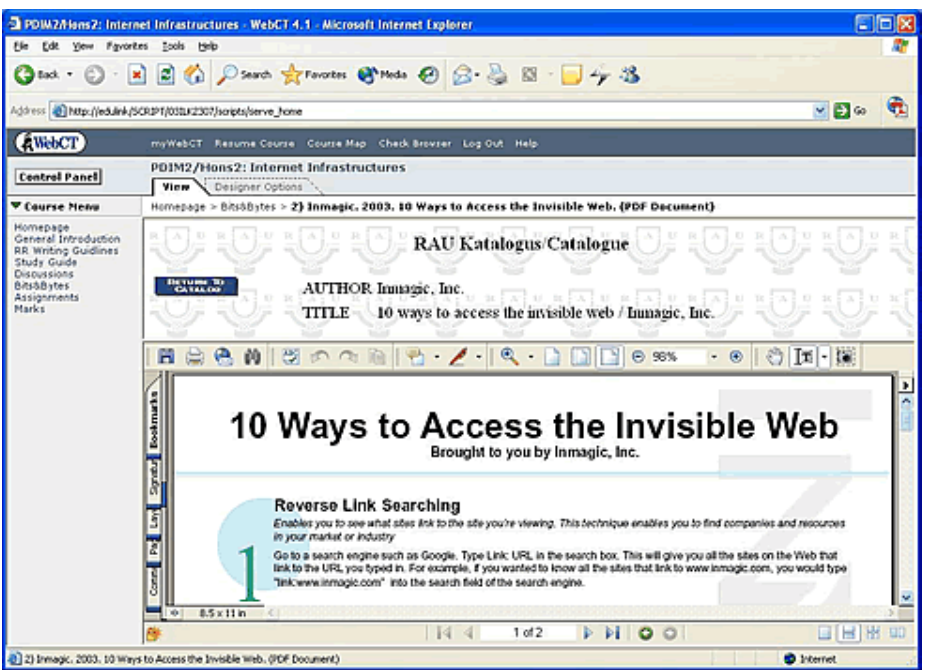
Figure 7 Example of an ECR document opened inside a WebCT